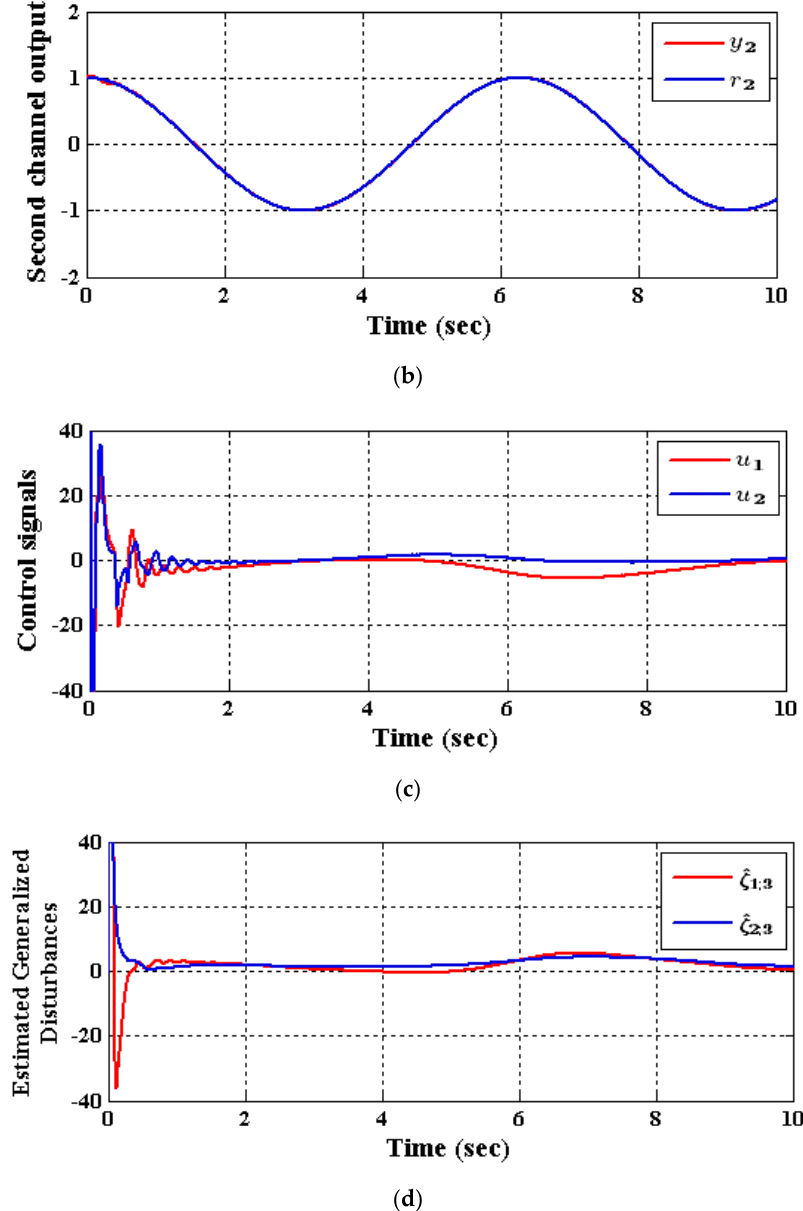
Figure 7. The output response of Equation (42) using IADRC, ( a ) output y 1 , ( b ) output y 2 , ( c ) control signals u 1 and u 2 , and ( d ) estimated generalized disturbances ˆ ξ 1,3 and ˆ ξ 2,3